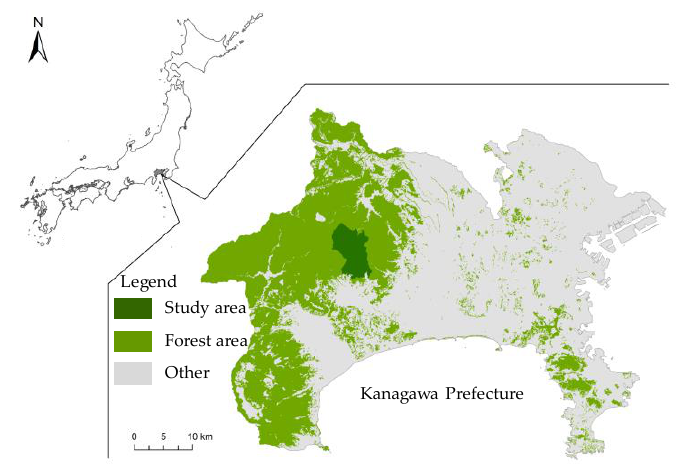
Figure 1. The study area in Kanagawa Prefecture.